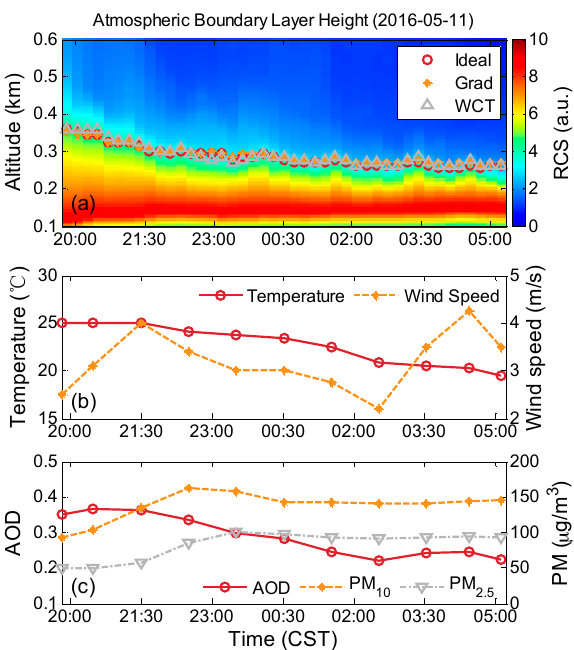
Figure 2. Case measured from 19:40 on 11 May 2016 to 05:20 on 12 May 2015 CST: ( a ) nocturnal boundary layer height obtained by elastic LiDAR; ( b ) temperature and wind speed; and ( c ) PM 2.5 and PM 10 .